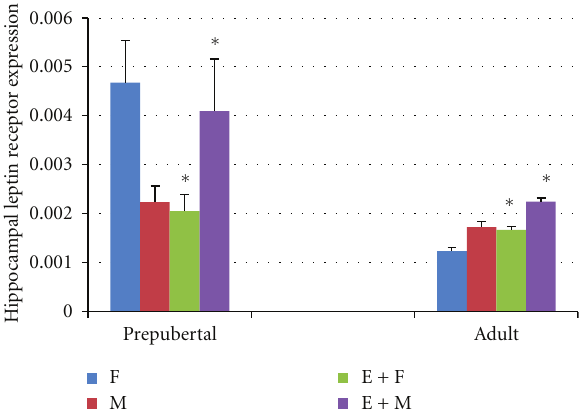
Figure 3: Hippocampal leptin receptor expression of the groups. ∗ P < 0 . 05 compared to other groups. F: control female pups, M: control male pups, E + F: female pups whose mothers exercised during pregnancy, E + M: male pups whose mothers exercised during